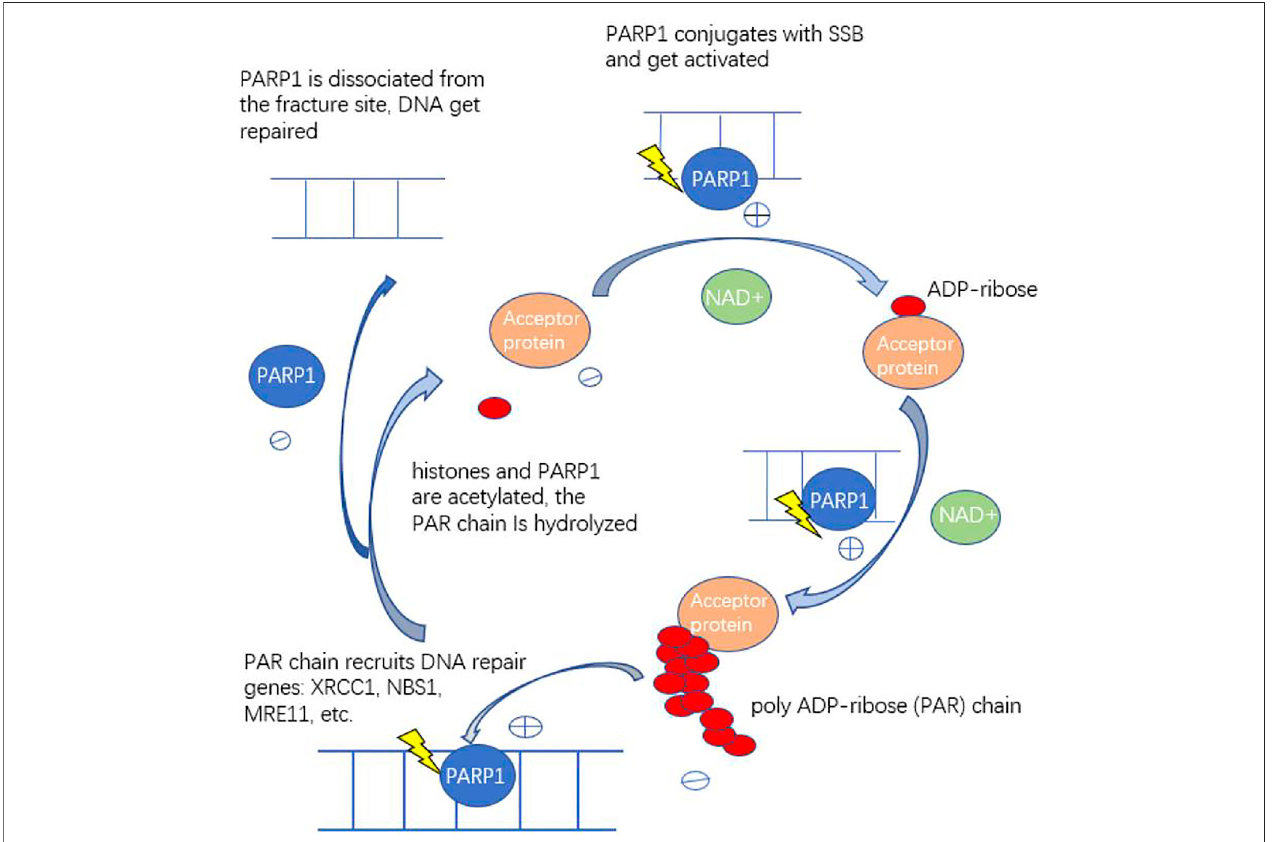
FIGURE 1 | The mechanism of action of PARP1. PARP1 binds to DNA nicks and breaks, which results in activation of catalytic activity causing poly (ADP) ribosylation of PARP1 itself, and of acceptor proteins. The components of DNA repair pathways will be recruited, then DNA get repaired. PARP: poly ADP-ribose polymerase: PAR: poly ADP-ribose: SSB: single-strand